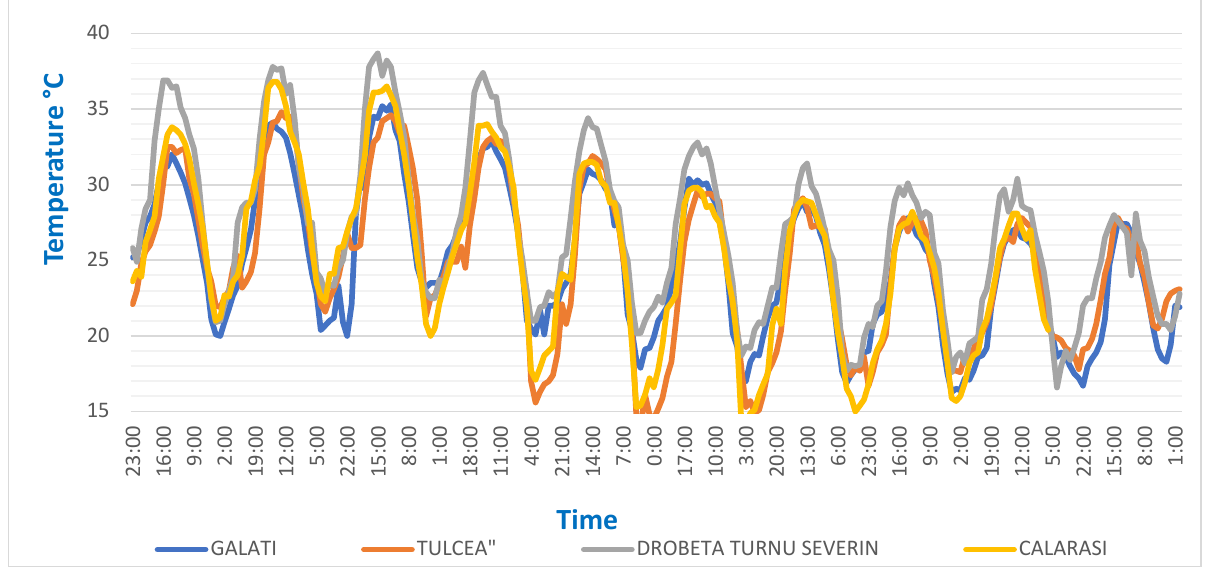
Figure 2. Time series of temperatures 21–30 July 2021 (data processed from reference [33]).